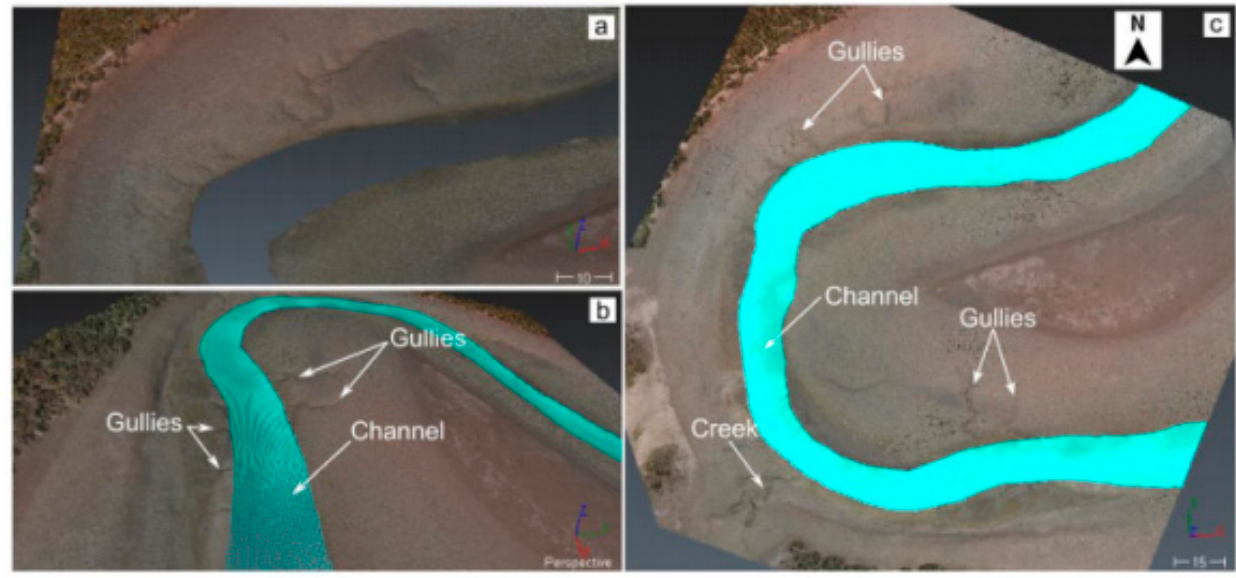
Figure 5. Different views of point clouds: ( a ) TPC; ( b , c ) topobathymetric point cloud presenting the combination of two data sources and its main terrain characteristics according to [30].